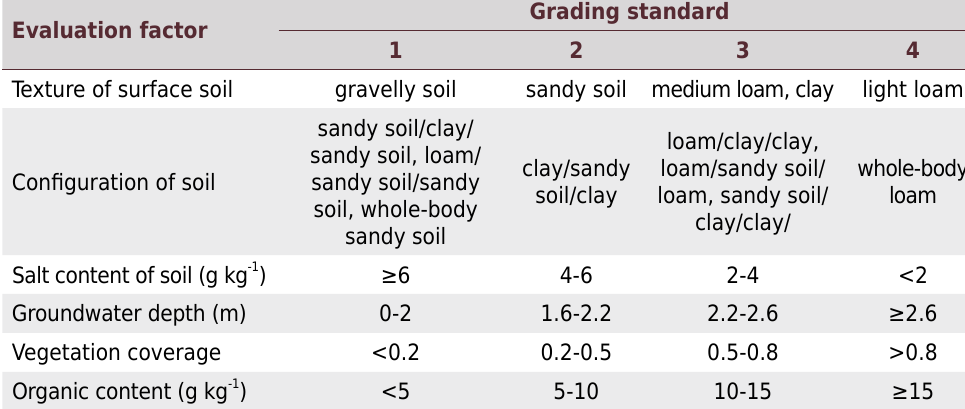
Table 1. Evaluation index values for the ecosystem suitability of unutilized land Evaluation